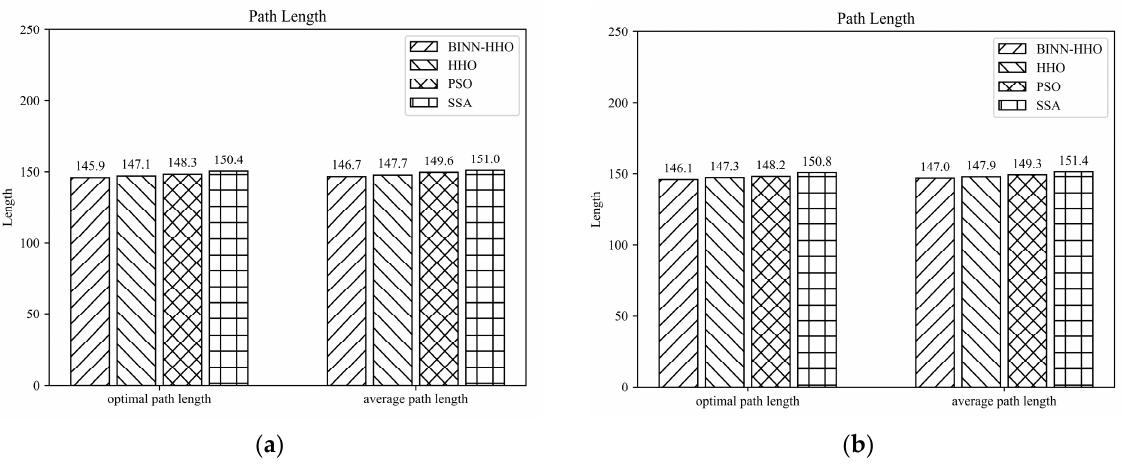
Figure 17. Multi-UAV path planning results of BINN-HHO in a dynamic environment (unit: km). ( a ) Dynamic case I. ( b ) Dynamic case